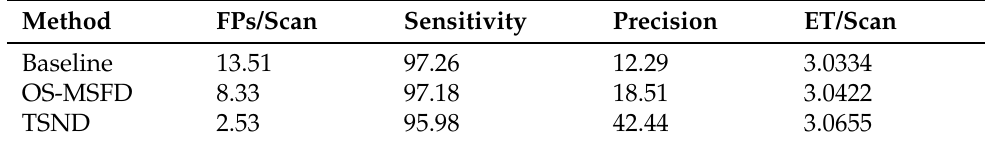
Table 3. Comparison of candidate detection results of three proposed methods on LUNA16 dataset using LUNA16 CAD Performance and their average execution times (unit:s) per scan (ET/Scan).